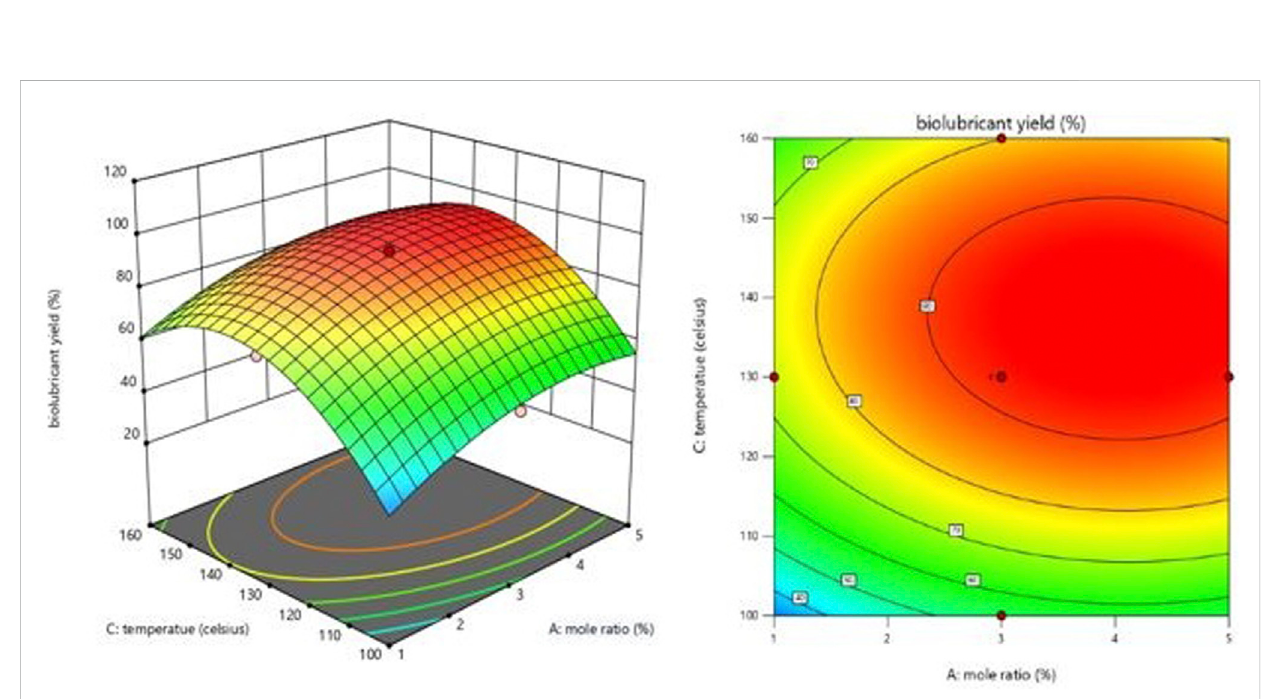
FIGURE 6 Effect of the interaction of temperature and mole ratio (EG-TO-FAME) on biolubricant yield.